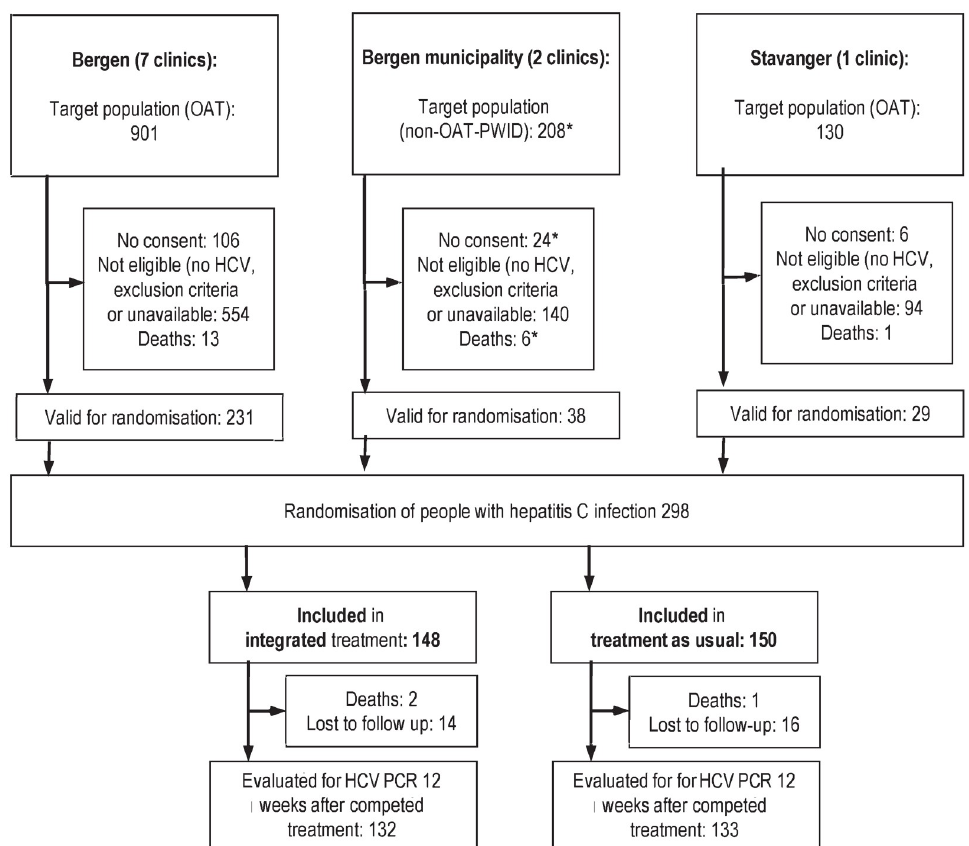
Fig 1. Trial profile for the study. � Estimated numbers. HCV, hepatitis C infection; OAT, opioid agonist therapy; PWID, people who inject drugs.